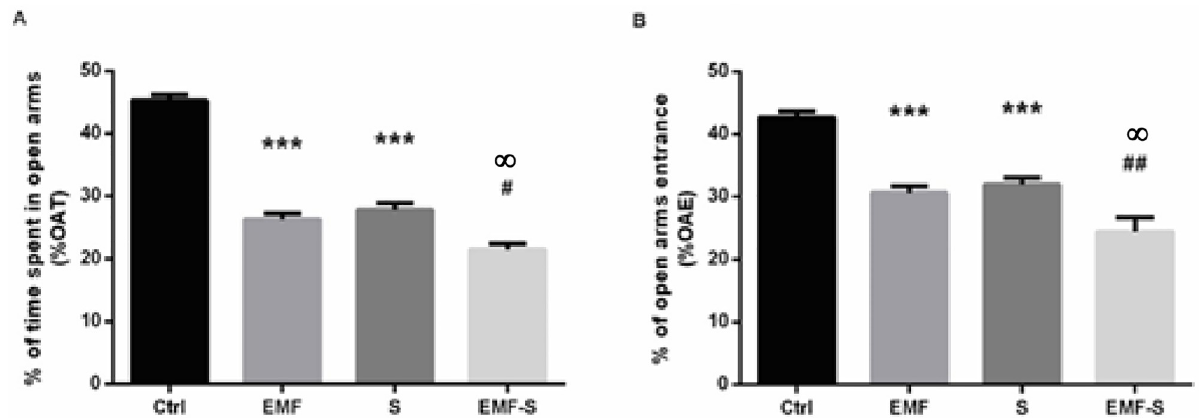
Fig 5. Effect of EMF on open arm time (%OAT) and open arm entries (%OAE) in plus maze test after prenatal stress. Graphs show the %OAT (A) and %OAE (B). Data are shown as mean ± SEM (n = 6 per group). Two-way ANOVA, followed by Tukey’s post hoc test: ��� p < 0.001 versus control group; #p < 0.05, versus stress group; ##p < 0.01; versus stress group; 1 P < 0.05, versus EMF. ANOVA, analysis of variance; Ctrl, Control; EMF, Electromagnetic Field; S, Stress.